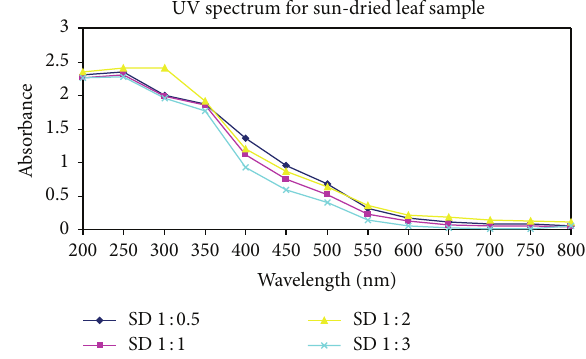
Figure 3: UV-Vis absorption spectra recorded as a function of time of reaction of four different solutions of silver ions by Pimenta dioica sun-dried leaves extract in ratios of 1:0.5, 1:1, 1:2, and 1:3 after 10 minutes reaction